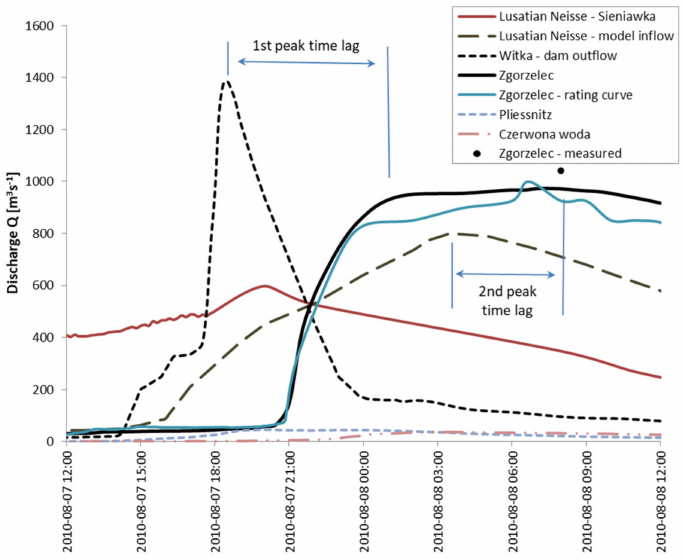
Figure 14. Hydrographs of discharges of the Witka and the Lusatian Neisse